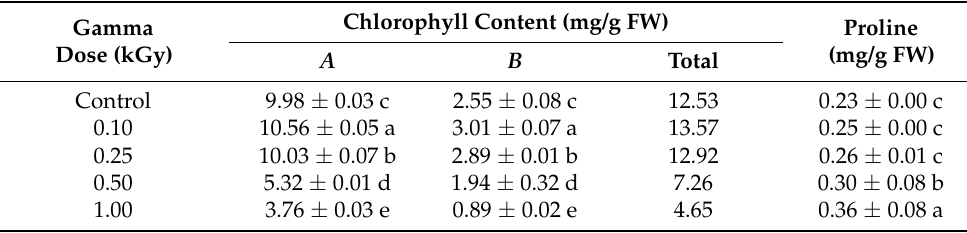
Table 6. Effect of gamma irradiation on chlorophyll (a and b) and total proline content of wheat, T. vulgare leaves in 2019/2020 growing season. Gamma